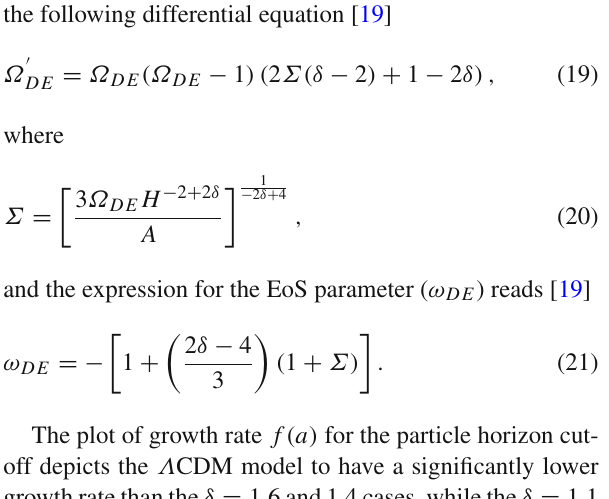
minima occurs at a DE = 0 . 62 which corresponds to a